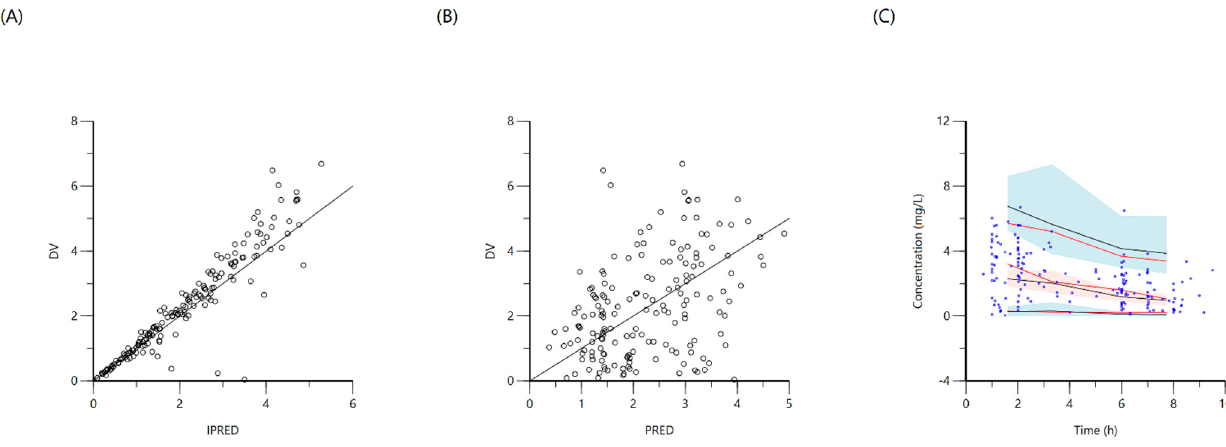
Figure 3. Goodness-of-fit plots for final population models of isoniazid. Plot ( A ) represents individual predicted concen- trations (IPRED) versus observed concentrations (DV), whereas plot ( B ) represents population-predicted concentrations (PRED) versus observed concentrations (DV). Plot ( C ), visual predictive check (VPC) for concentrations of isoniazid versus time based on 1000 Monte Carlo simulations. The blue circles represent observed isoniazid concentrations; solid red lines represent the 5th, 50th and 95th percentiles of the observed concentrations; solid black lines represent the 5th, 50th and 95th percentiles of the simulated concentrations; and the shaded area represent the 90% CI of the 5th, 50th and 95th percentiles of the simulated concentrations.